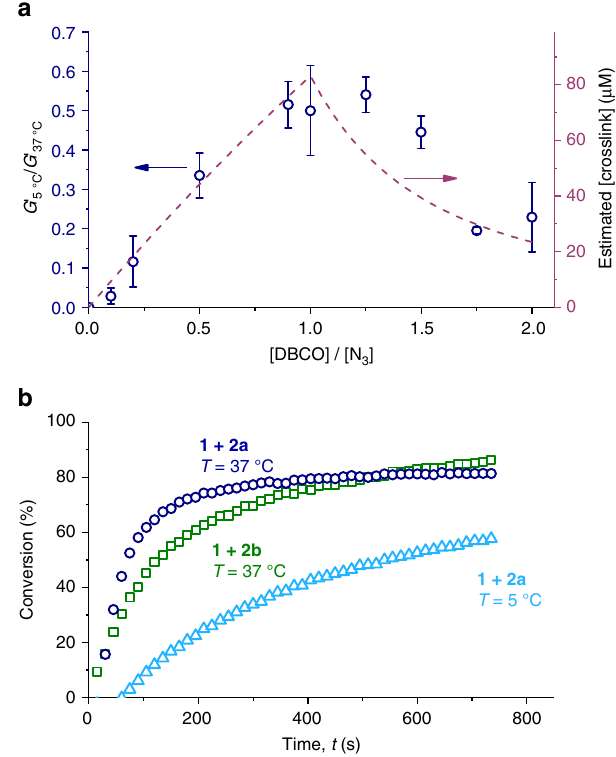
Fig. 4 Crosslinker ratios and conversions. a Relative stiffness of crosslinked 1 + 2a hydrogels ( T cl = 37 °C, [ 1 ] = 1 mg mL − 1 ), after 11 h stabilization at 5 ° C as compared to the stiffness of the same gel at 37 °C as a function of the [DBCO]/[N 3 ] ratio (blue data). The error bars represent the standard deviation of n = 2 or 3 measurements. The ratio of [DBCO]/[N 3 ] was varied between 0 and 2. Note that the graph shows the relative decrease of the modulus at 5 °C that is normalized to the modulus at 37 °C, because the DBCO units that are present at different concentrations for different crosslinking ratios shift the gel transition temperature slightly, and with that the stiffness of the gel. The absolute values of the moduli at T = 5 °C and 37 °C are given in Supplementary Table 1. Estimated crosslink concentration based on statistical reactions between the crosslinker and the azide and the experimentally determined conversion values (red dotted line). b DBCO conversion for gels crosslinked with 2a or 2b , at 37 °C and at 5 °C in time measured using UV – vis spectrometry. Colors are explained in the